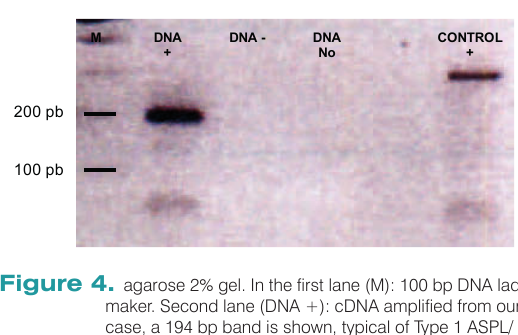
Figure 4. agarose 2% gel. In the fi rst lane (M): 100 bp DNA ladder maker. Second lane (DNA +): cDNA amplifi ed from our case, a 194 bp band is shown, typical of Type 1 ASPL/ TFE3 fusion. Third lane (DNA -): cDNA without RT enzyme. Fourth lane (DNA No): negative control for RT enzyme amplifi cation. Fifth lane (Control +): Positive